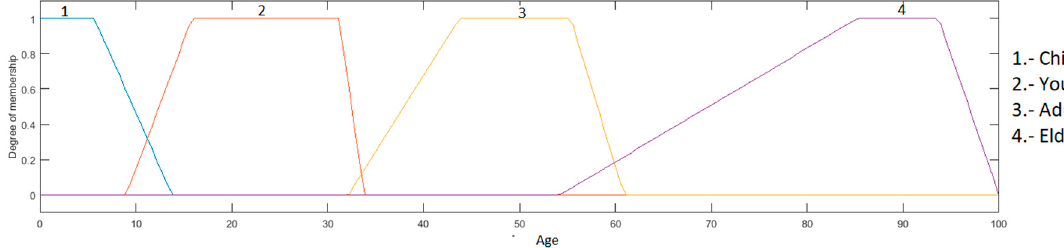
Figure 19. Optimized input age.